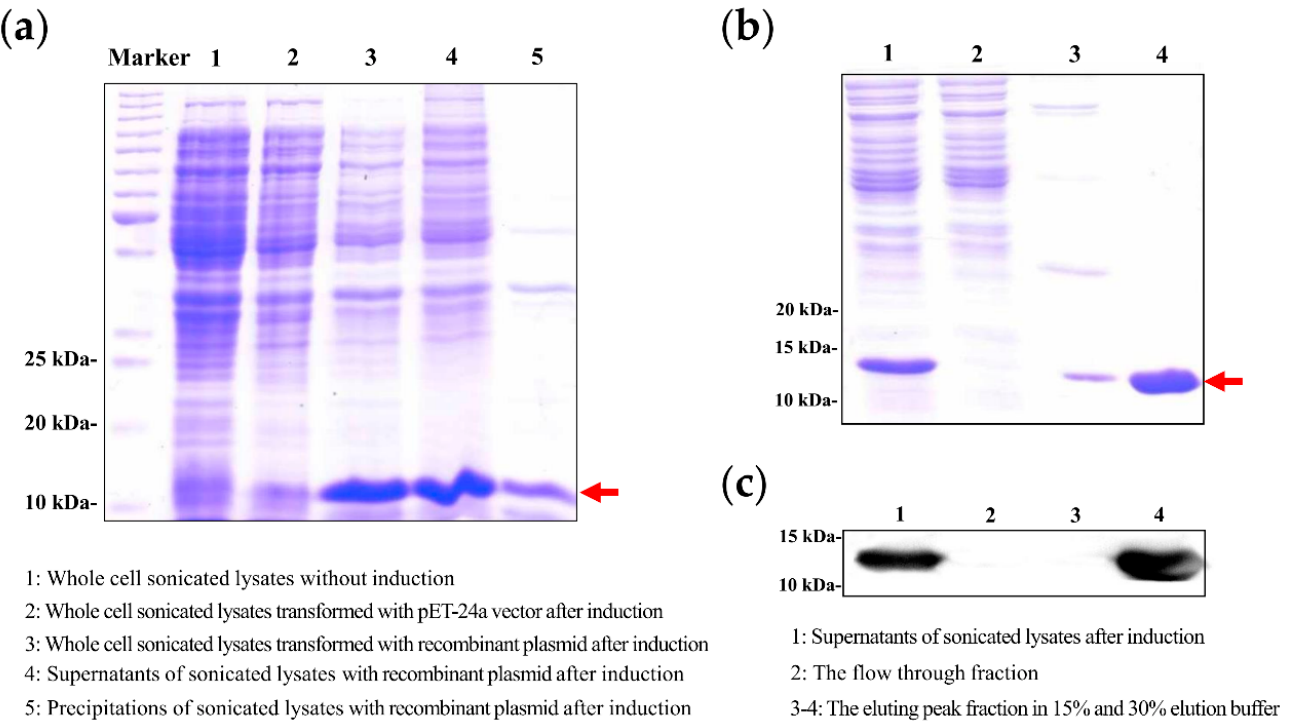
Figure 1. Expression, purification, and identification of PTD-CcTrx1. Recombinant PTD-CcTrx1 plasmids were transformed into E. coli BL21, and then induced by 0.2 mM IPTG with shaking for 18 h at 37 °C. Cell pellets were collected, resuspended, and sonicated, and then centrifugated at 12,000× g for 30 min at 4 °C. The supernatants containing PTD-CcTrx1 were purified via the ÄKTA purifier system using a 5 mL HisTrap HP Chelating column. ( a ) SDS-PAGE analysis of the samples under different expression conditions. ( b ) SDS-PAGE analysis of the samples collected from different steps of purification. ( c ) Western blot analysis of the samples collected from different steps of purification using the anti-His-tag antibody. The position corresponding to PTD-CcTrx1 is indicated by the red arrow.